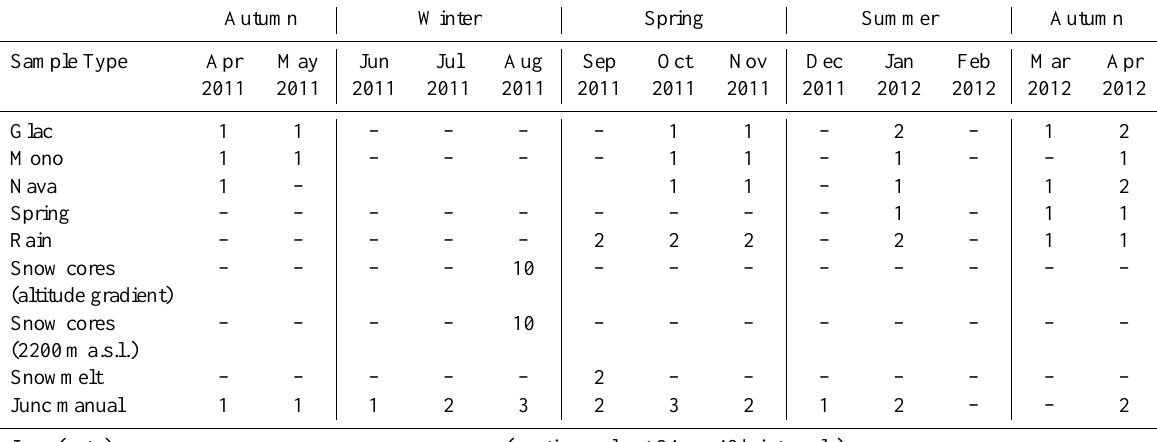
Table 1. Overview of all samples collected in the study. Autumn Winter Spring Summer Autumn Sample Type Apr May Jun Jul Aug Sep Oct Glac – – – – – – Mono 1 1 – – – – – – – Nava 1 – – Spring – – – – – – – – – – 1 Rain – – – – – Snow cores – – – – 10 – – – – – – – – (altitude gradient) Snow cores – – – – – – (2200ma.s.l.) Snowmelt – – Junc (auto) (continuously at 24- or 48h